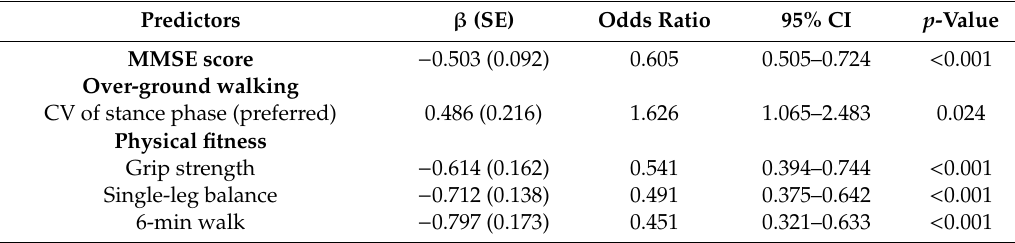
Table 2. Summary of binary logistic regression model for identifying participants aged over 75